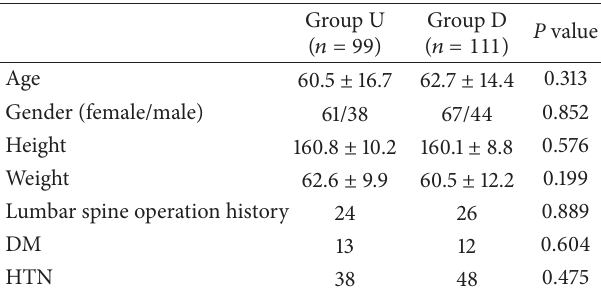
Table 4: Demographic data of the patients treated in group U and group